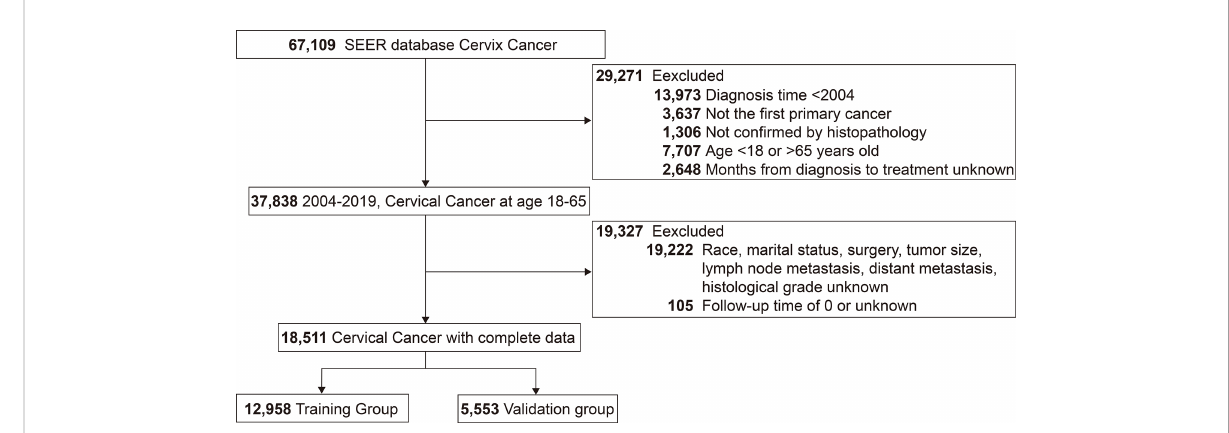
FIGURE 1 Flow chart for screening patients with cervical cancer. SEER, the Surveillance, Epidemiology, and End Results.